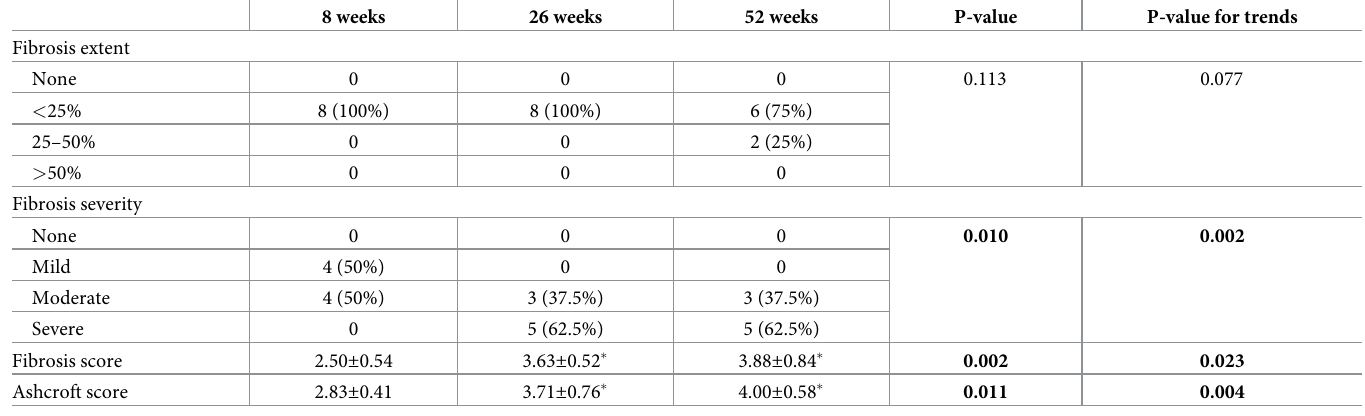
Table 3. The extent and severity of fibrosis after PHMG exposure.